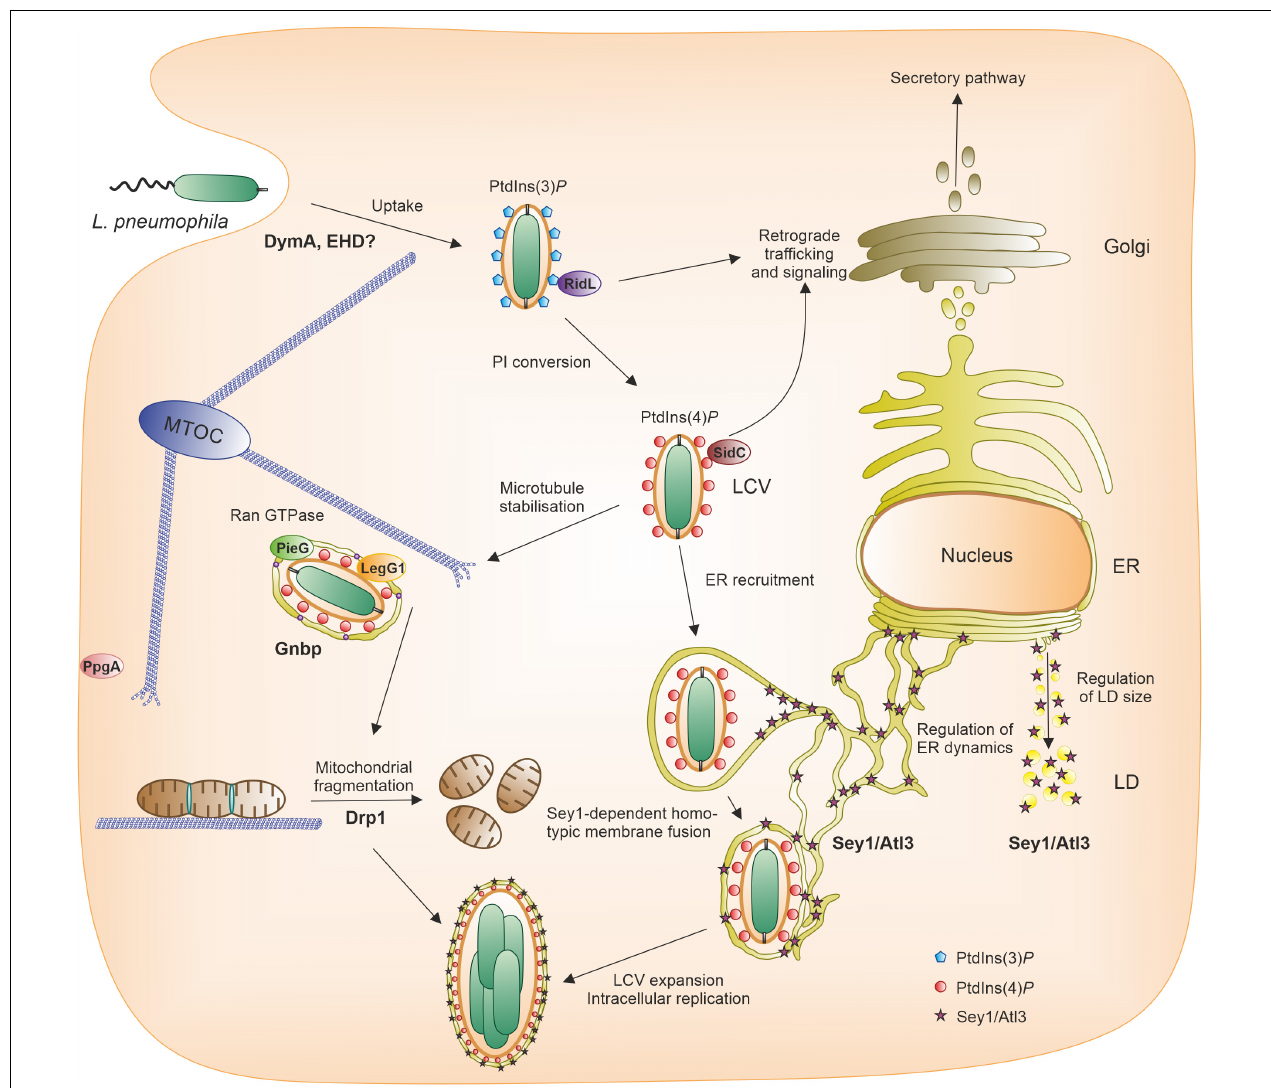
FIGURE 1 | Pathogen vacuole formation and intracellular replication of L. pneumophila . Following uptake of L. pneumophila by the host cell, a unique pathogen vacuole forms, the Legionella -containing vacuole (LCV). The LCV restricts interactions with lysosomes, but communicates with the endosomal, secretory and retrograde trafficking pathways and finally intimately associates with the ER. A hallmark of LCV maturation is the phosphoinositide (PI) lipid conversion from the endosomal PtdIns(3) P to the secretory PtdIns(4) P , both of which serve as membrane anchors of distinct L. pneumophila effector proteins (e.g., RidL, SidC). The RCC1 repeat domain effectors LegG1/MitF, PieG or PpgA localize to the LCV or the plasma membrane, respectively, and activate the small GTPase Ran to stabilize microtubules. In the course of LCV maturation, large GTPases also play a role. The dynamin superfamily protein (DSP) Sey1/Atl3 catalyzes pathogen vacuole expansion, the fission DSP Drp1 promotes intracellular bacterial replication by modulating mitochondrial fusion/fission dynamics, and the scaffold DSP Gnbp localizes to the pathogen vacuole. The D. discoideum DSP DymA and EHD possibly play a role for bacterial uptake. Accordingly, different DSPs play a role in LCV formation either in cis (on the LCV) or in trans (in a distance from the LCV). ER, endoplasmic reticulum; LCV, Legionella -containing vacuole; LD, lipid droplet; MTOC, microtubule organizing center; PI,